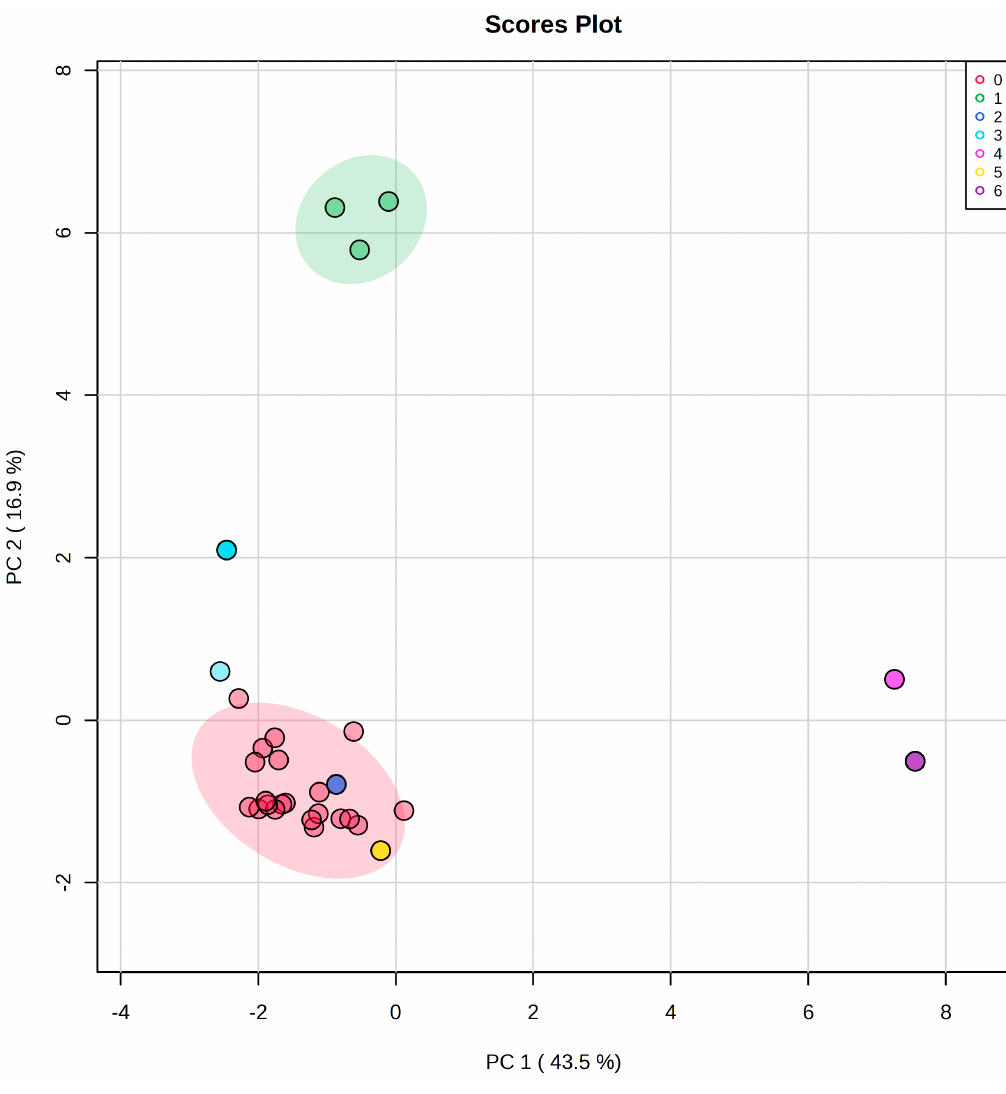
Figure 2. PCA scores plot of distilleries using HS-SPME-GCMS data. Shaded areas are the 95% confidence regions .